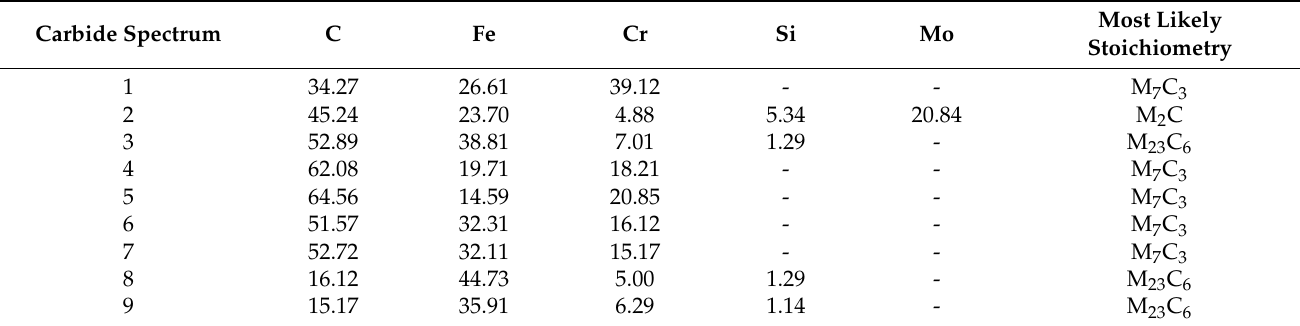
Table 4. Semiquantitative analysis of the carbides indicated with arrows in Figure 2. Semiquantitative compositions determined by EDX microprobe analysis, expressed in atomic percent. The most likely stoichiometry type is shown.